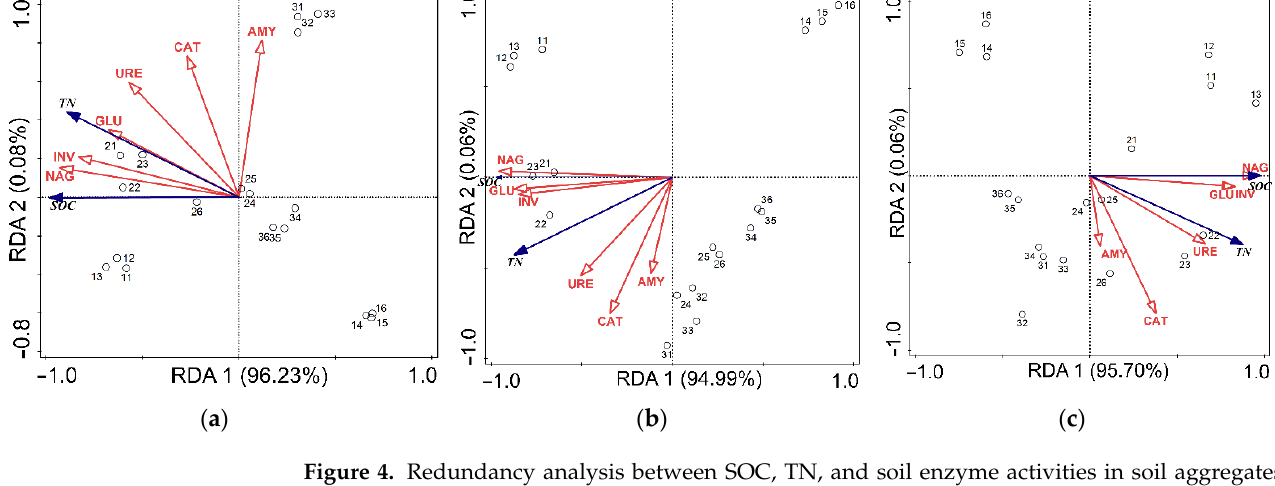
Table 3. Importance and significance levels of soil enzyme activities in soil aggregates.